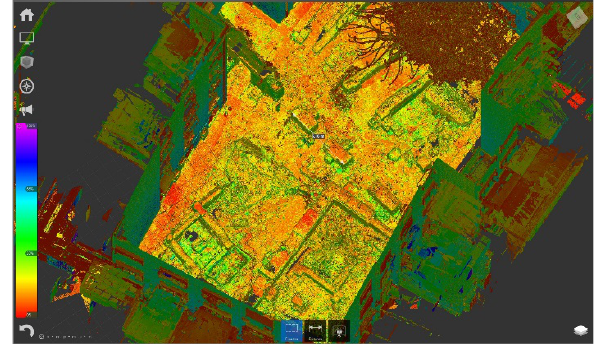
Fig. 14 Range data acquisition and elaboration in ReCap Pro.